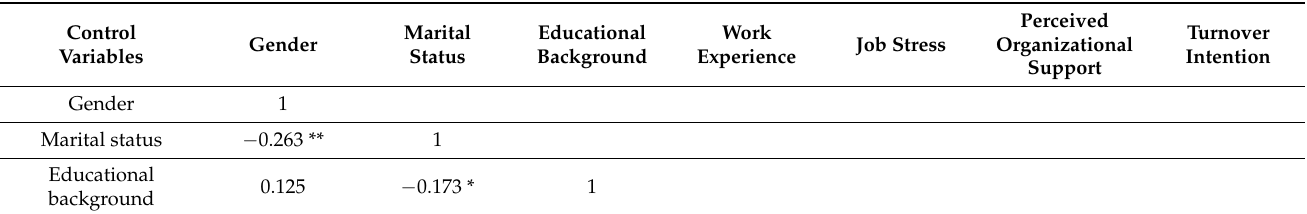
Table 5. Descriptive statistics (correlation matrix, mean, and standard deviation) ( n =